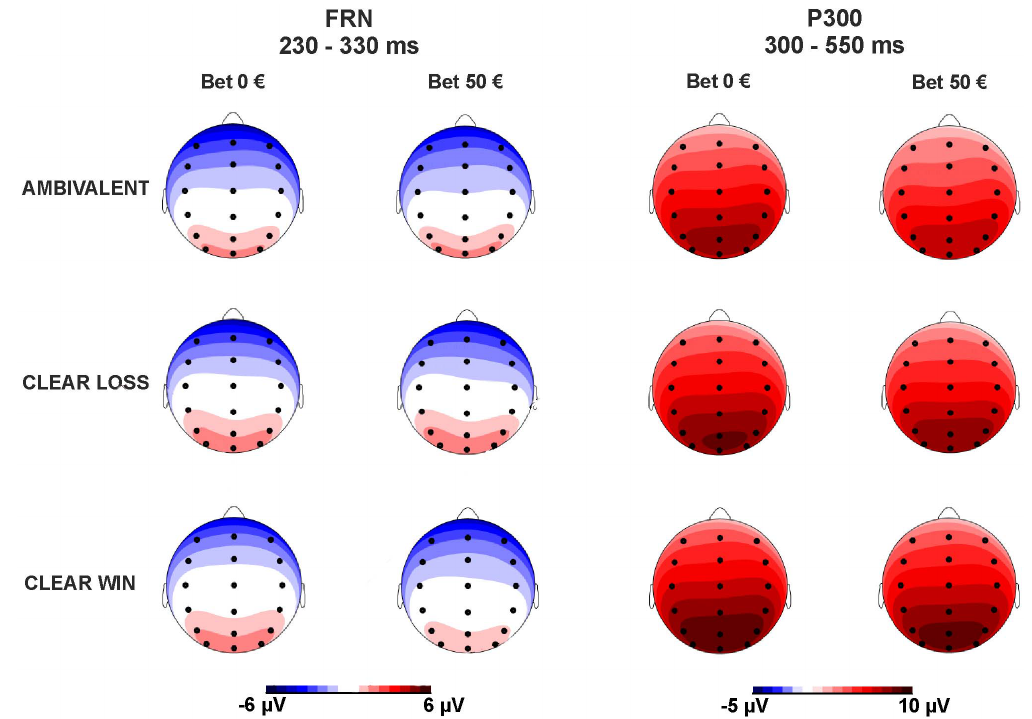
Figure 3. Scalp topographies of FRN and P300 according to initial bet (0 J or 50 J ) and outcome (clear win, ambivalent or clear loss). Note that for illustrative reasons, FRN amplitudes are displayed relative to the preceding positive peak, i.e. the P200. For the P300, mean absolute amplitudes are displayed.